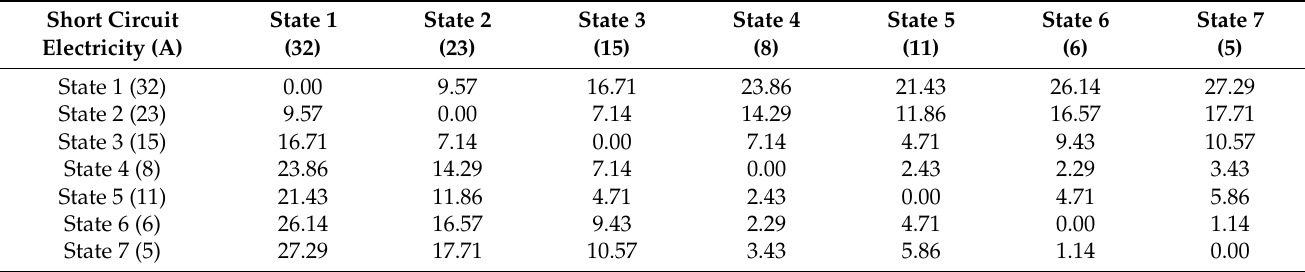
Table 4. The decision matrix for the PV criterion (short circuit electricity) with differences between the quality of states for this criterion according to